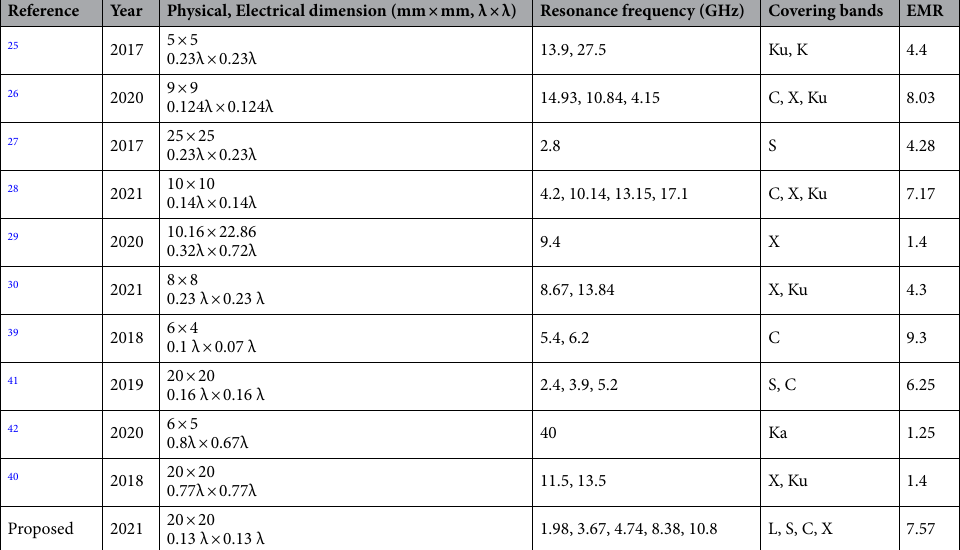
Table 4. Comparison of the performance of the proposed MTM with some other existing works.